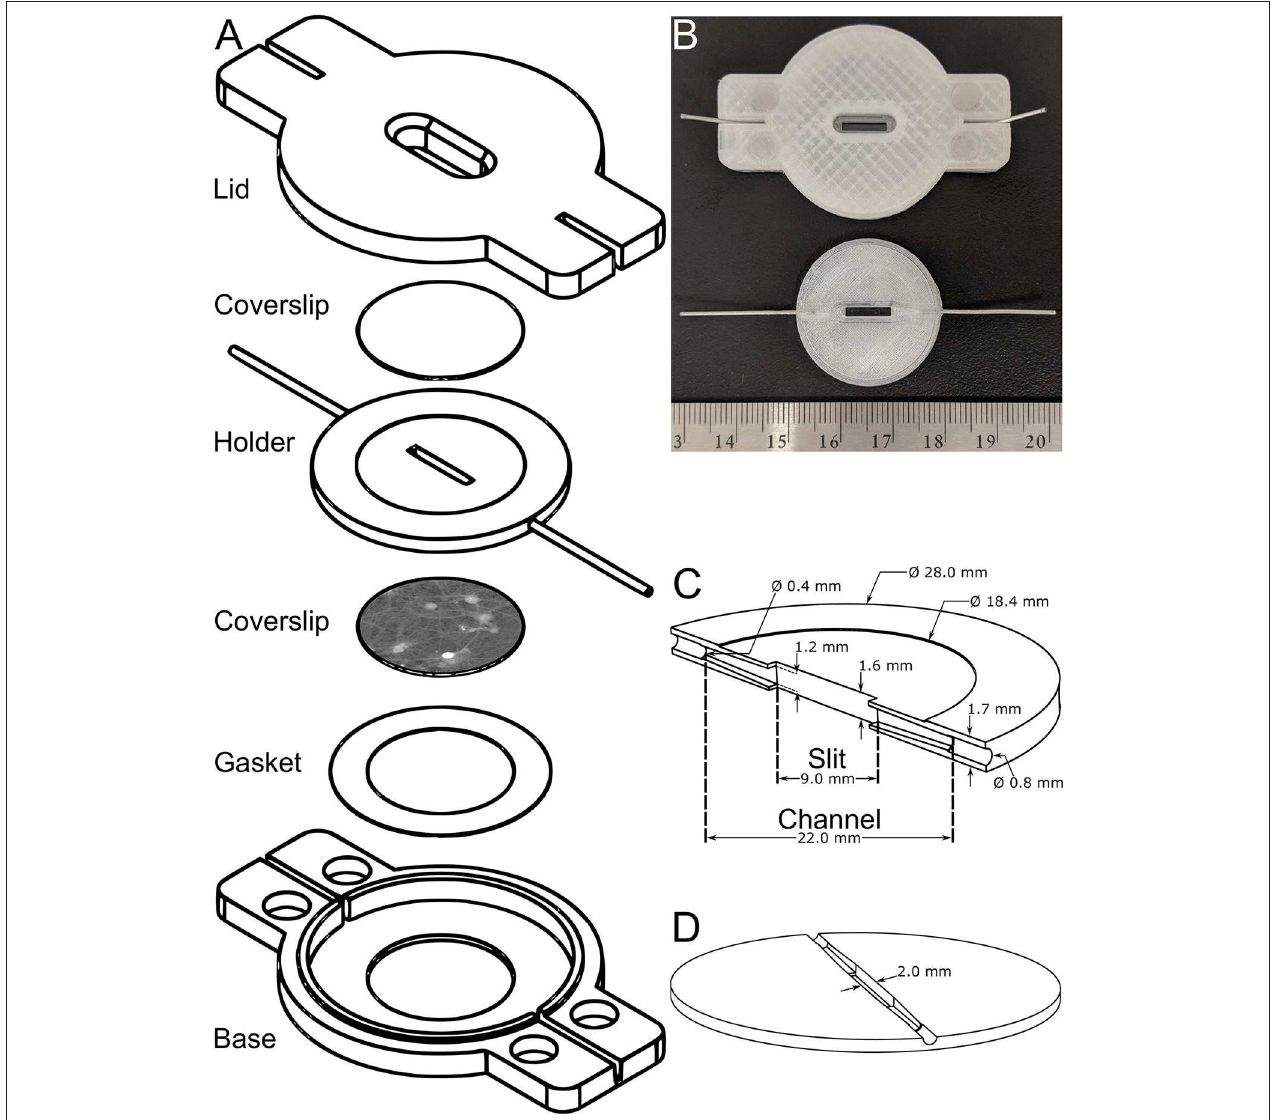
FIGURE 2 | Mechanical design. (A) An exploded CAD-model view representing the flow chamber and detailing its constituents. (B) Photograph showing the assembled flow chamber (top) and a sample holder (bottom) as well as a ruler, for sizing purposes. (C,D) CAD models of the sample holder showing, respectively, a vertical and horizontal cross-section of the channel highlighting the diffusers where the outlet of the stainless steel microtubes will be attached to the imaging